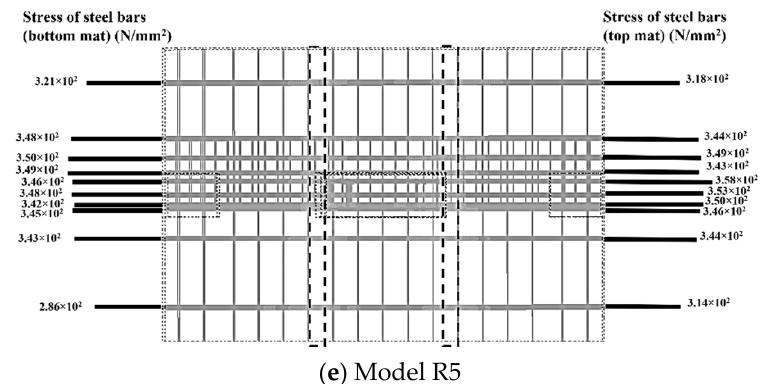
Figure 27. Stress and yield conditions for reinforcement distribution models.